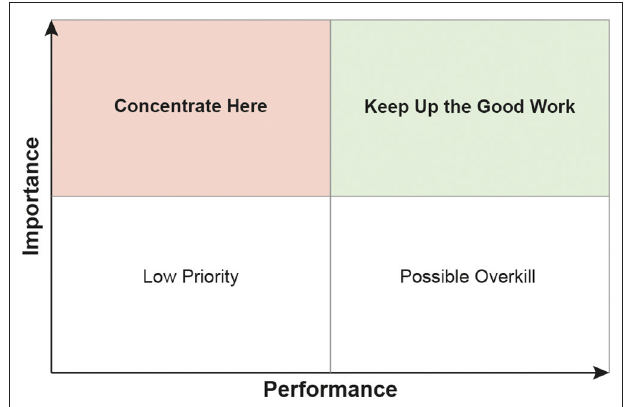
FIGURE 1 | Importance performance analysis (IPA = needs assessment) adapted from Park et al. (44). The importance of each theme is derived from the frequency (number of occurrences = in how many interviews it was coded), the performance by the categorization (learned vs.